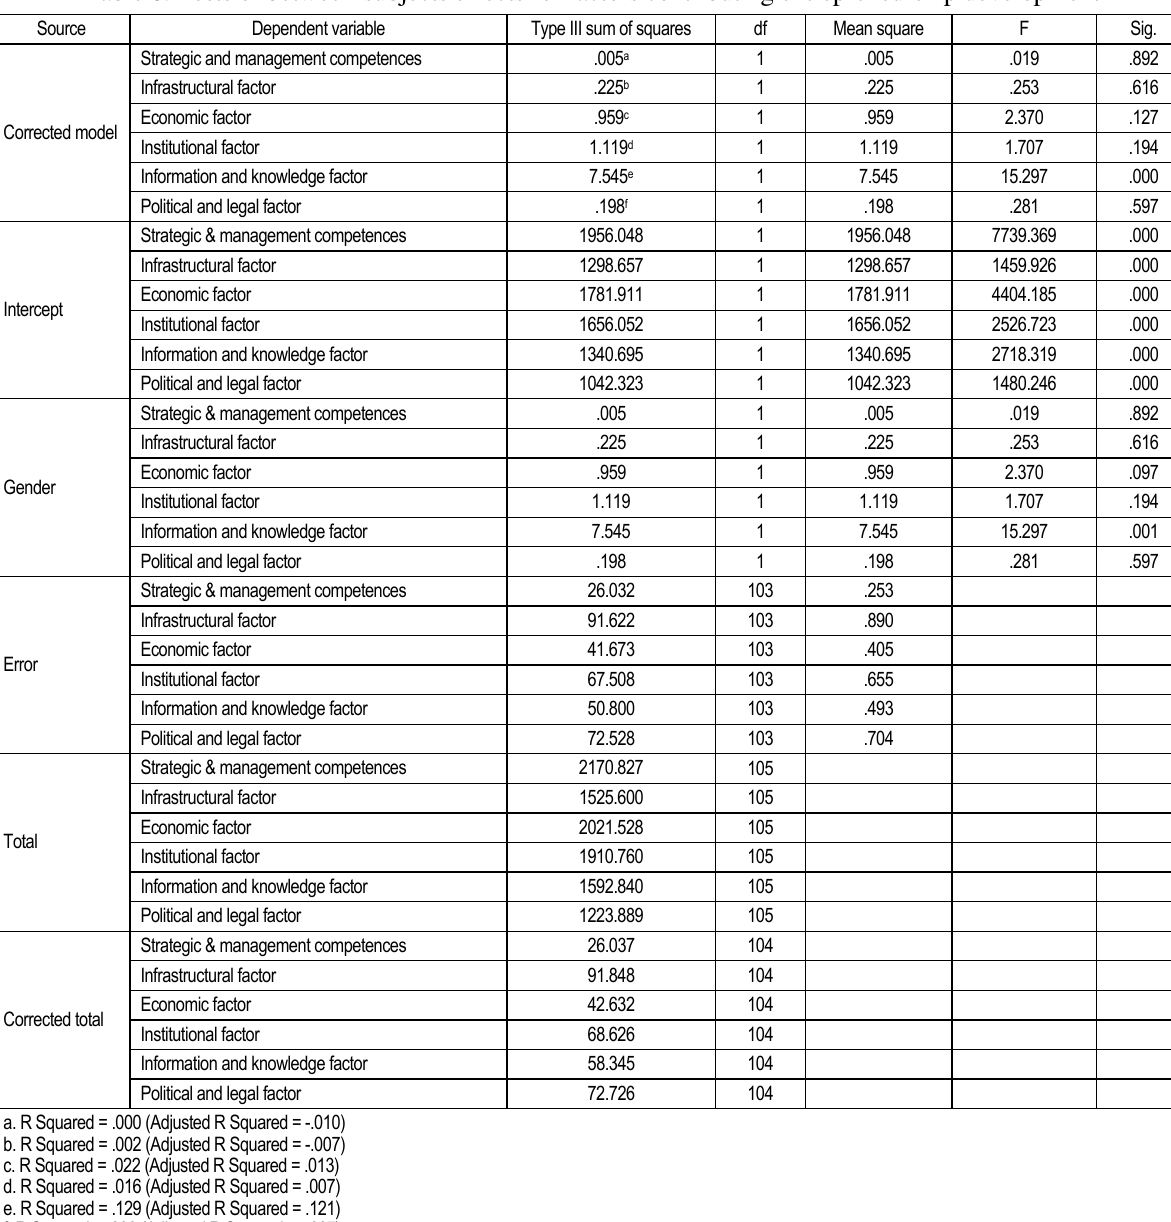
Table 8. Tests of between-subjects effects for factors contributing entrepreneurship development